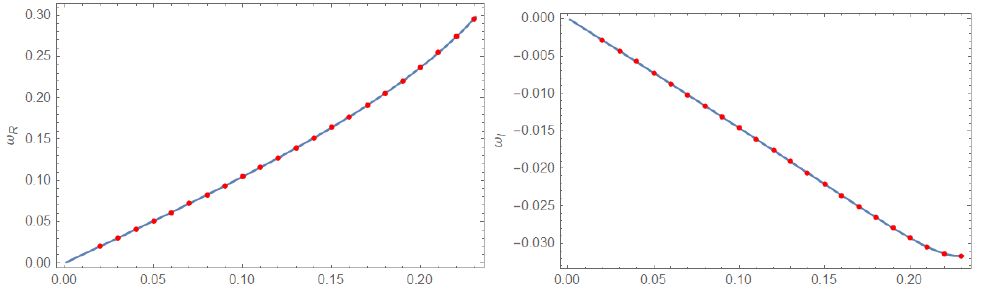
Figure 3. The comparison of QNM’s frequencies given by the WKB method and by time domain profiles. The lines are the results of WKB, and the dots are the frequencies extracted by the Prony method. The results show good consistency between the two